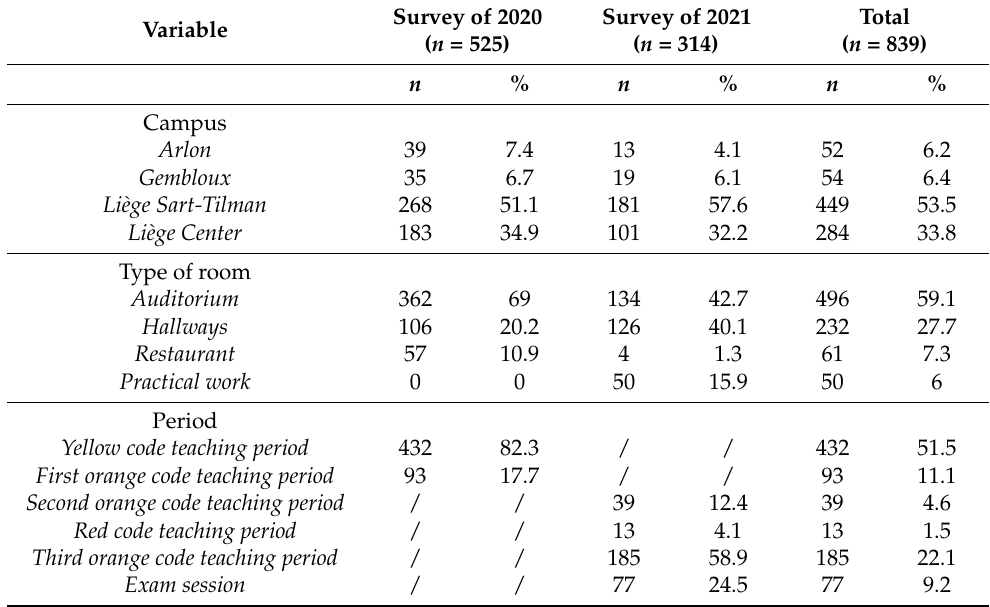
Table 1. Observation sessions of barrier gestures during both surveys (2020 and 2021).